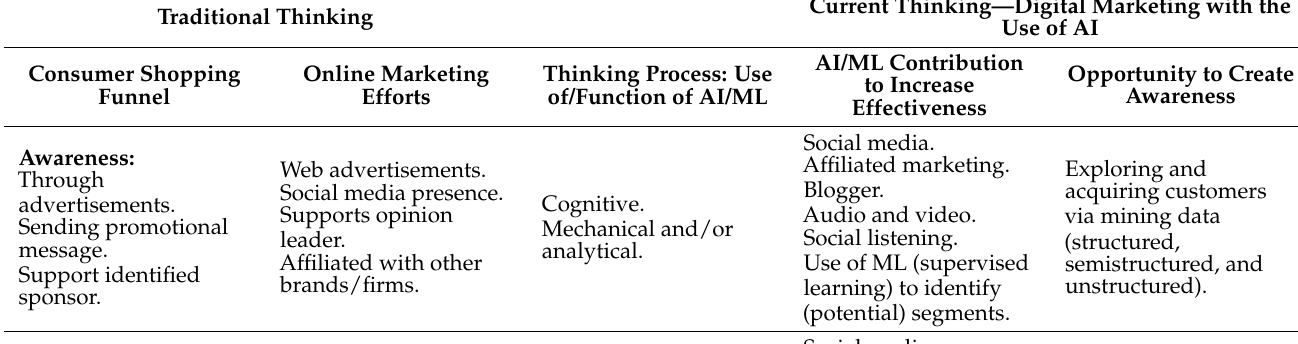
Table 2. How AI contributes to enhancing consumer